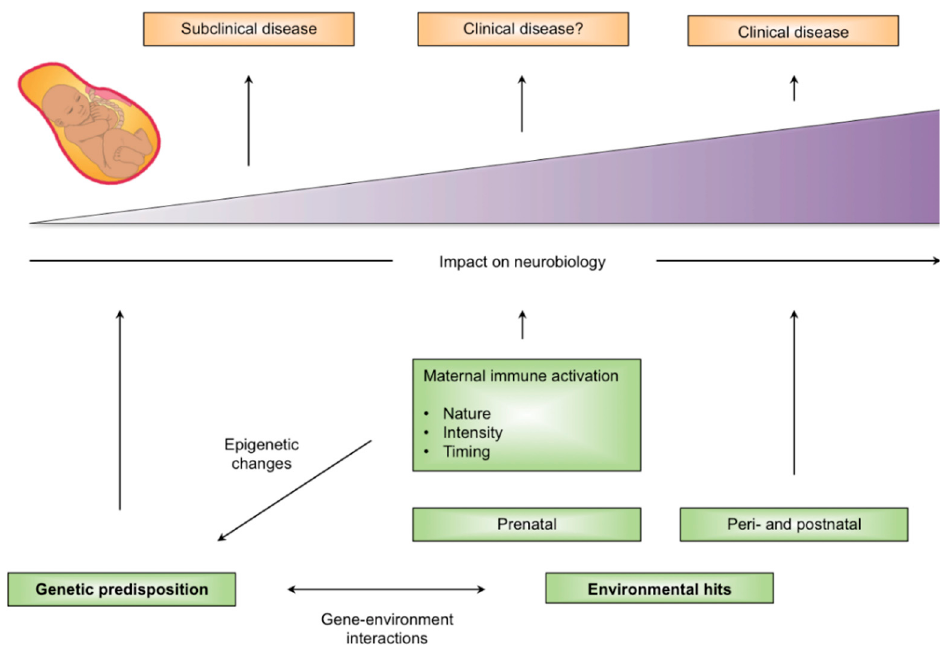
Figure 2. A priming/multi ‐ hit model for MIA and disease specificity.